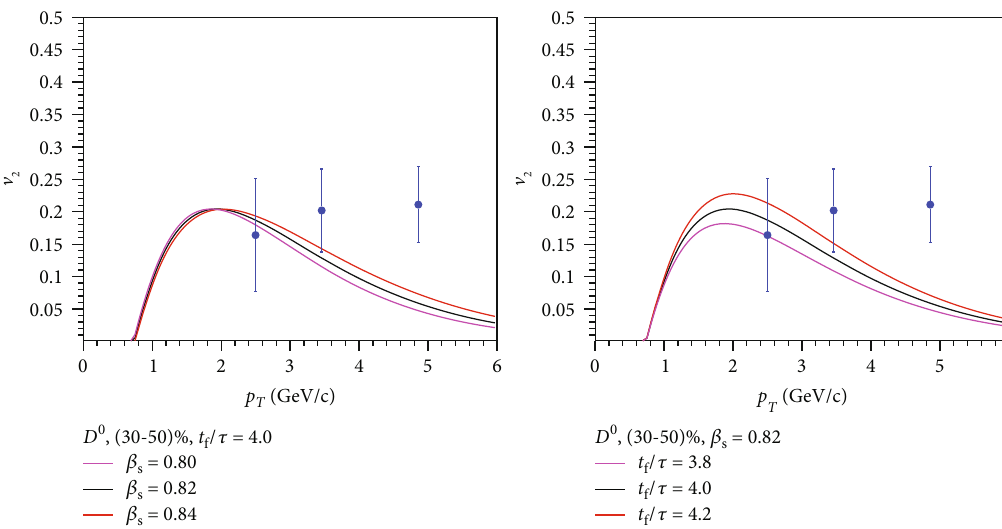
p ffiffiffiffiffiffiffiffi = 2 : 76 TeV . Symbols s NN